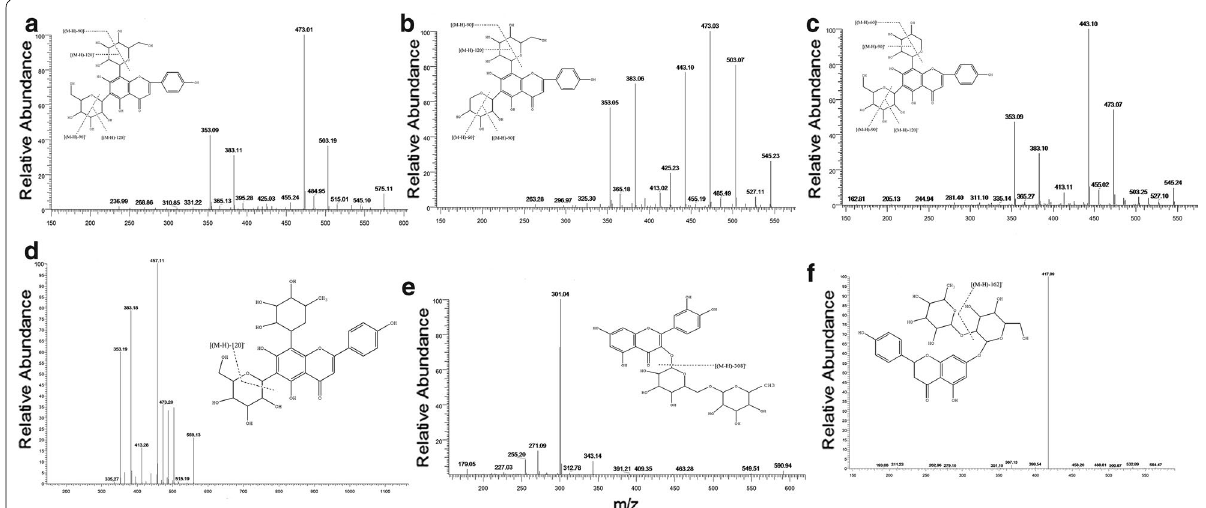
Fig. 3 Chimical structures and MS/MS spectra of 6 flavonoids, Apigenin-6,8-di-C-β-glucoside ( a ), Isoschaftoside ( b ), Schaftoside ( c ), Violanthin ( d ), Rutin ( e ), Naringin ( f